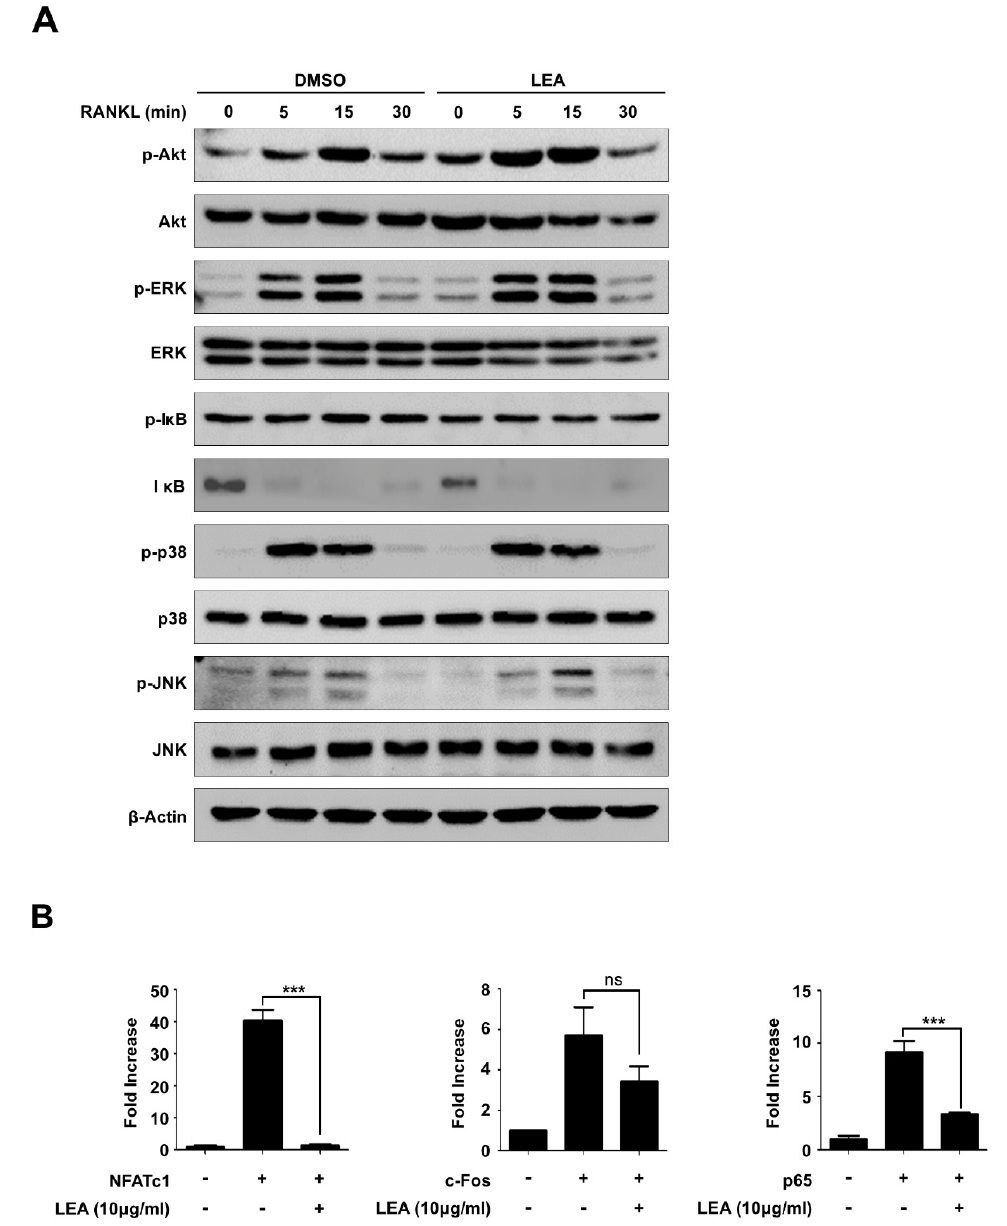
Figure 4. LEA suppresses NFATc1 expression by blocking both NF- κ B and NFATc1-mediated transactivity. ( A ) BMMs were pre-treated with DMSO and LEA (10 µ g / mL) for 1 h, and stimulated with RANKL for 0, 5, 15, and 30 min. The cells were lysed and immunoblotted with antibodies against p-Akt, Akt, p-ERK, ERK, p-I κ B, I κ B, p-p38, p38, p-JNK, and JNK. Band intensities were normalized to β -Actin control. ( B ) 293T cells were transiently transfected with the reporter plasmid Nfatc1-Luc along with c-Fos , p65 , or Nfatc1 in the presence or absence of LEA (10 µ g / mL). Luciferase activity was measured after 24 h post-transfection using Luciferase assay kit (Promega, Madison, WI, USA). Each bar represents the means ± S.D. of three independent experiments. *** p < 0.001. ns = not significant. 2.5. LEA Suppresses Prednisolone-Induced Osteoporosis in Zebrafish Larvae To examine the in vivo efficacy of LEA against osteoporosis, we employed zebrafish for this study since zebrafish are an ideal model system for the in vivo analysis of GIO [26,27].